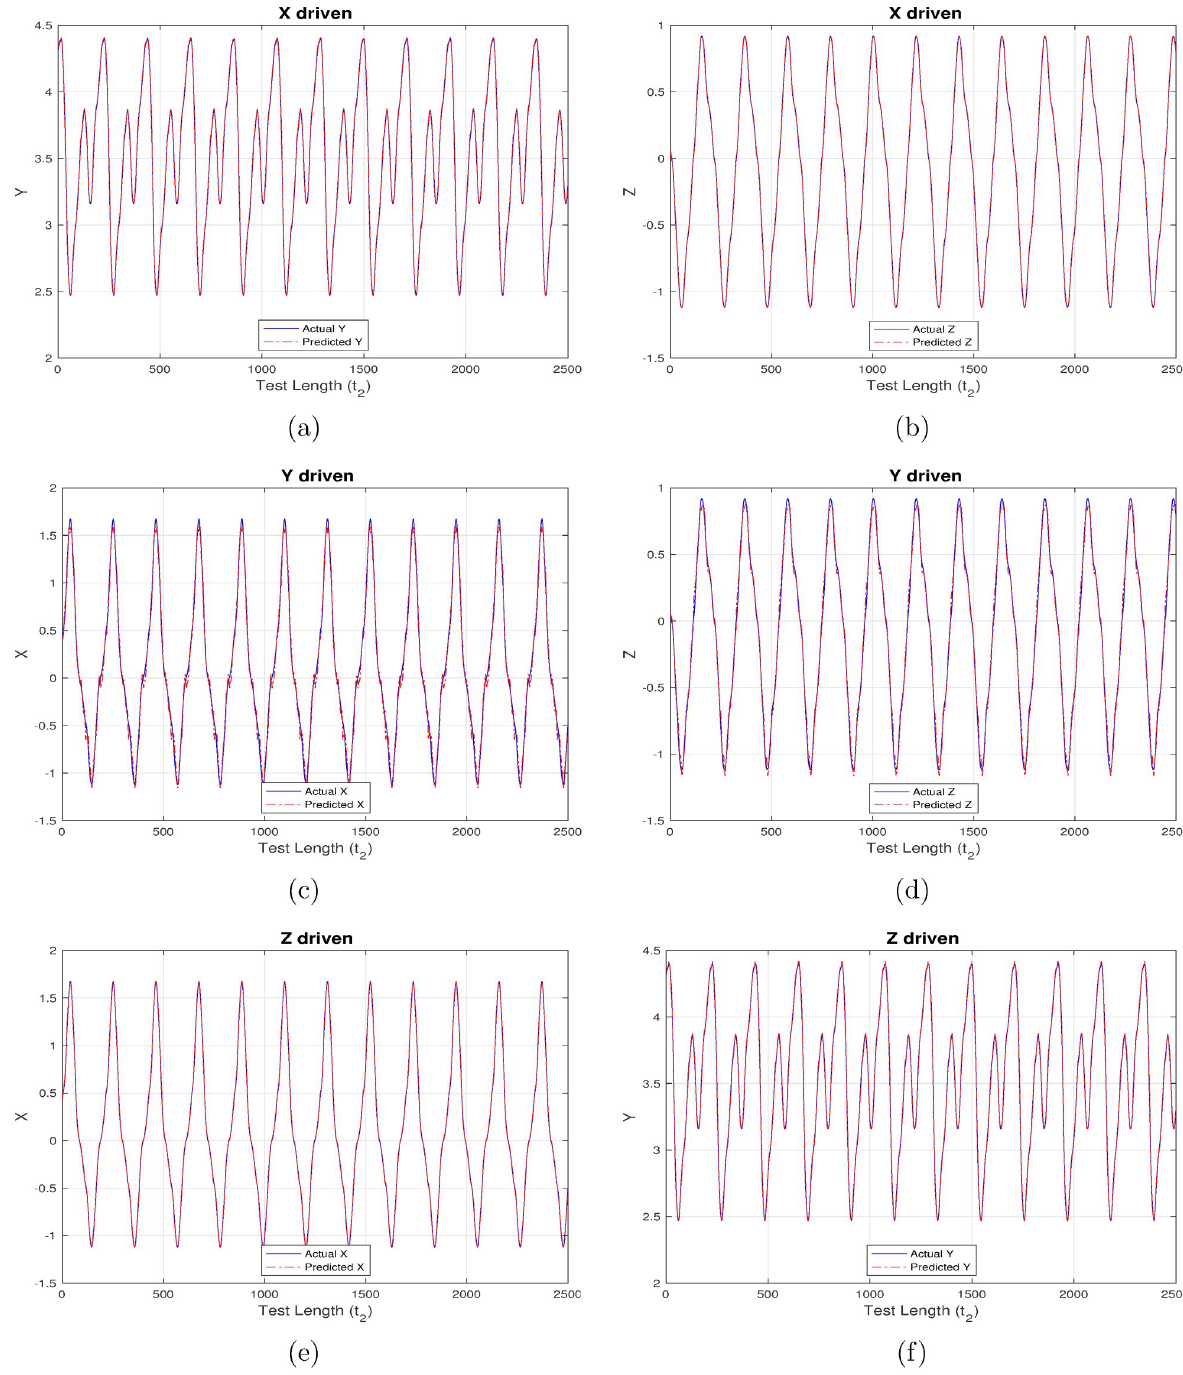
Fig 11. Controlled (time-delayed feedback) financial system component re-generation using “tanh” activation. (a) Re-generating “investment demand” [Y] behavior with “interest rate” [X] as input (b) Re-generating “price index” [Z] behavior with “interest rate” [X] as input (c) Re- generating “interest rate”[X] behavior with “investment demand”[Y] as input (d) Re-generating “price index” [Z] behavior with “investment demand” [Y] as input (e) Re-generating “interest rate” [X] behavior with “price index” [Z] as input (f) Re-generating “investment demand” [Y] behavior with “price index” [Z] as